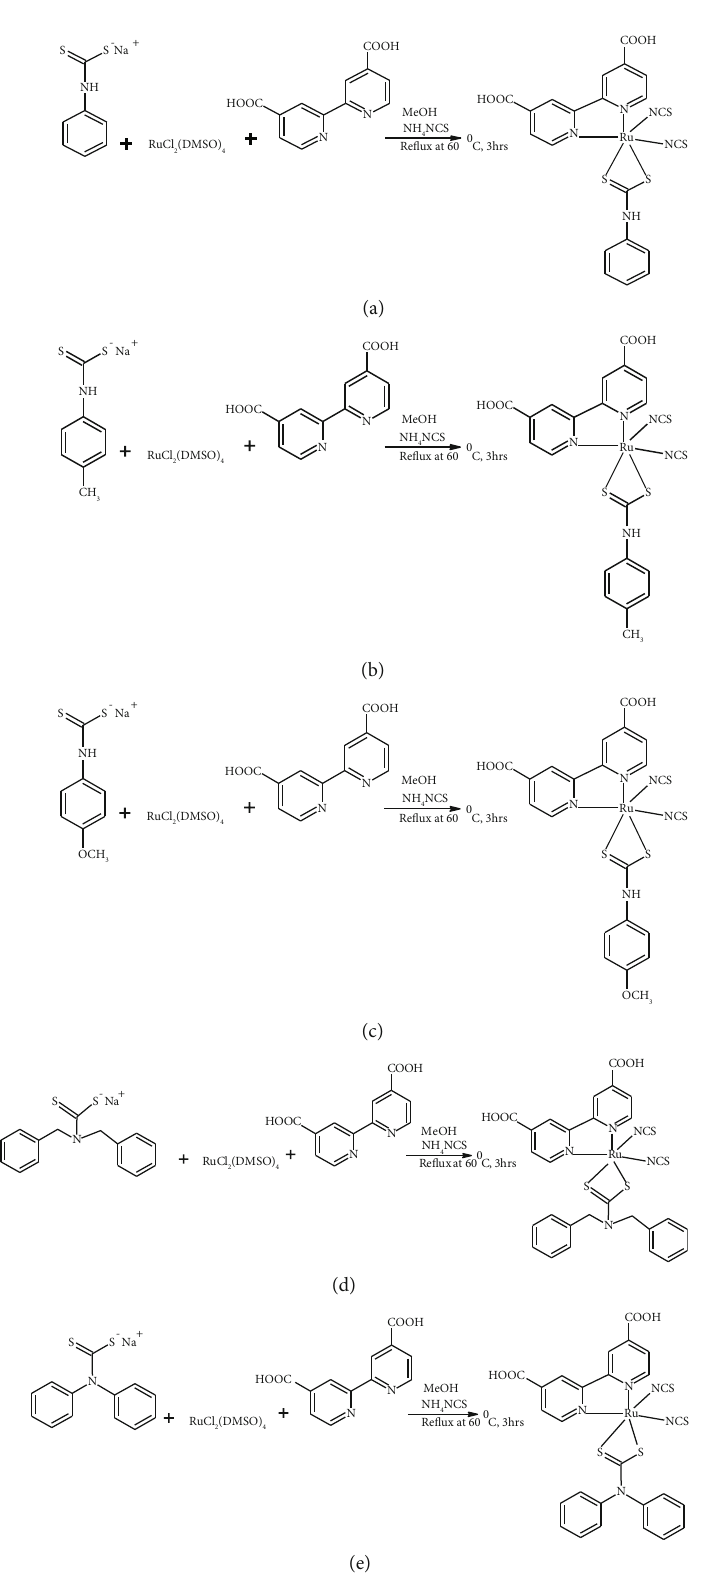
Scheme 1: Synthetic pathways of Ru(II) bipyridyl-dithiocarbamate complexes for (a) FC